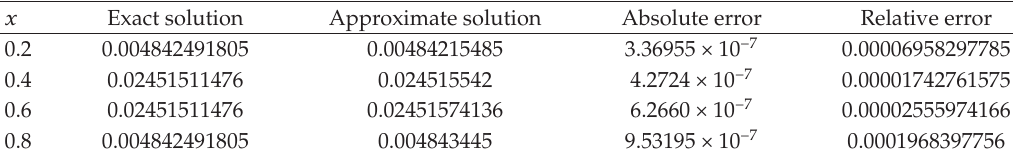
Table 5: The exact solution, approximate solution, absolute error, and relative error of Example 4.3 for initial conditions at t (cid:3) 1.